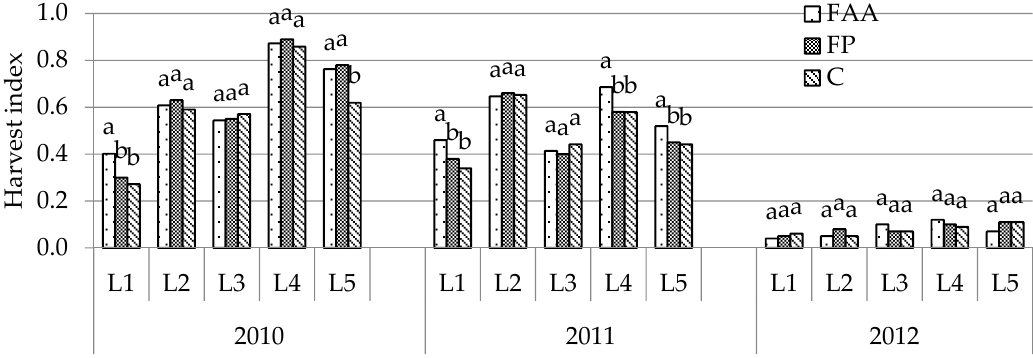
Figure 3. Effects of applied fertilizers on maize harvest index. L1–L5—maize lines. FAA—amino acid foliar fertilizer, FP—phosphate foliar fertilizer, C—control. L1—FAO 200; L2—FAO 300; L3—FAO 500; L4—FAO 600; L5—FAO 600. Averages followed by the same letter do not differ by LSD test at α = 0.05.